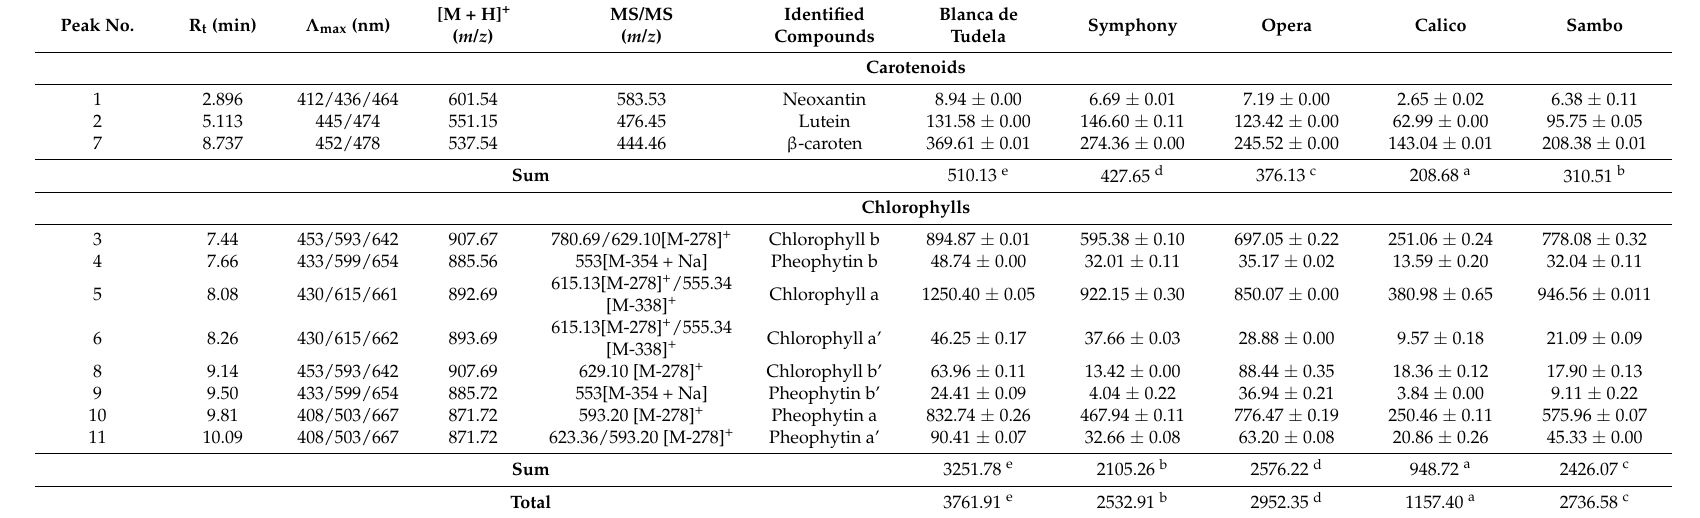
Table 2. Carotenoid and chlorophyll composition in artichoke bracts (mg/kg of dry matter). Peak